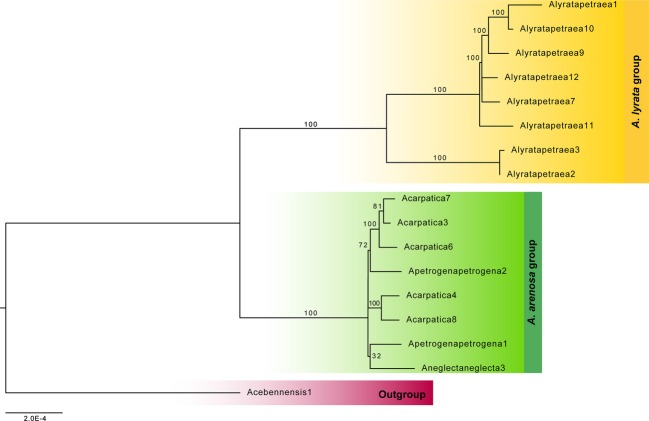
Comparison of chloroplast substitution rates between A. arenosa and A. lyrata, using Arabidopsis cebennensis as an outgroup. The maximum likelihood tree depicts rates of synonymous and nonsynonymous substitution based on ∼127 kbp from whole chloroplast genome sequences. Values indicate node support; bootstrap values estimated using RAxML (Stamatakis 2014). The rate differences between A. arenosa and A. lyrata for whole genome sequences were highly significant based on the relative rate test (Tajima 1993) implemented in MEGA (Tamura et al. 2013). TableA2 summarizes the results of relative rate tests performed for all pairwise heterospecific comparisons in MEGA (including both synonymous and nonsynonymous sites). All comparisons exhibited a significant difference in rates between the two species at the P = 0.01 threshold (without corrections for multiple testing).